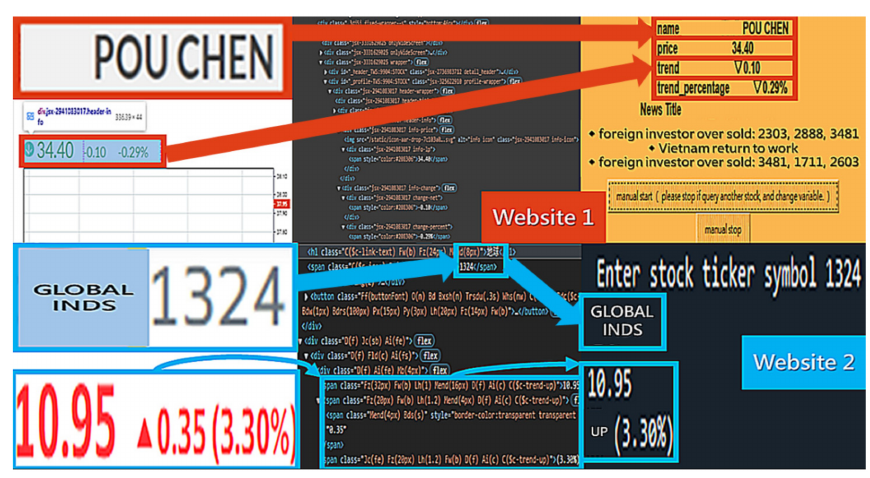
Figure 7. Example of scraping stock